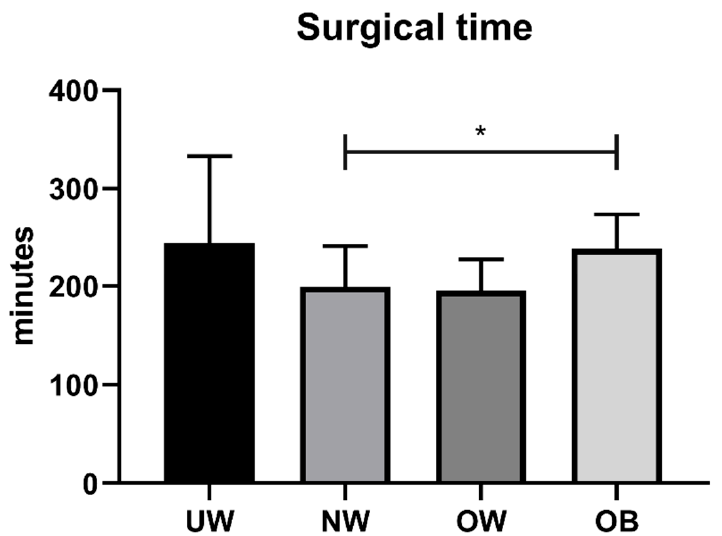
Figure 5. Surgical time in different BMI classes (UW, BMI% ≤ 5; NW, 5 < BMI% ≤ 84; OW, 84 < BMI% < 95; OB, BMI% ≥ 95). * p < 0.05.